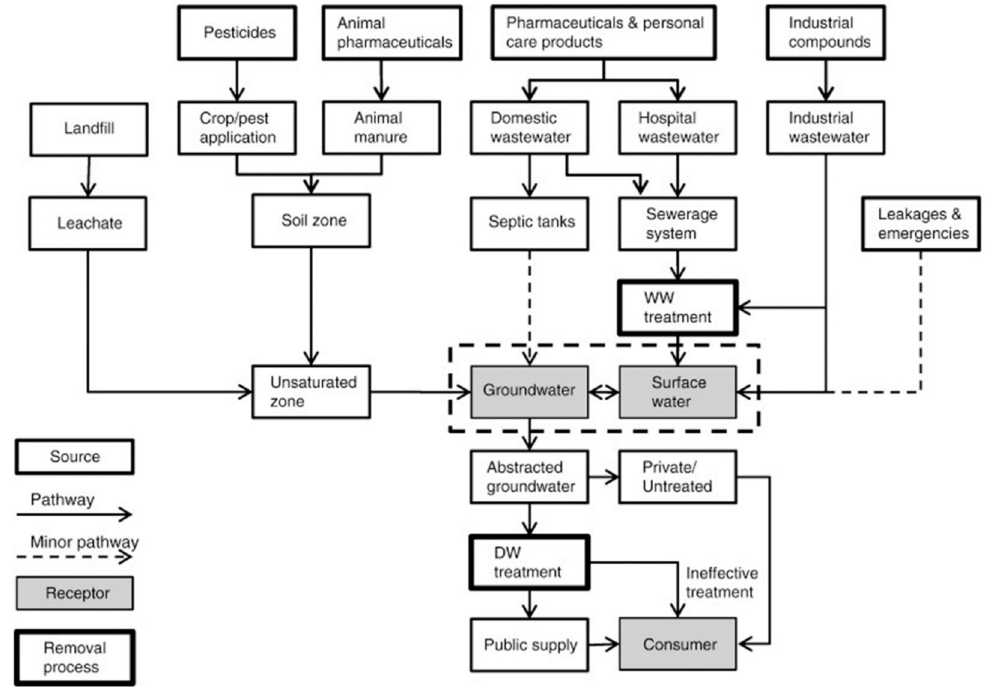
Figure 1. Sources and potential routes of EPs in the water environment [25]. (Reproduced from [25] with Elsevier permission, license 5191080813331, from 16 November 2021).